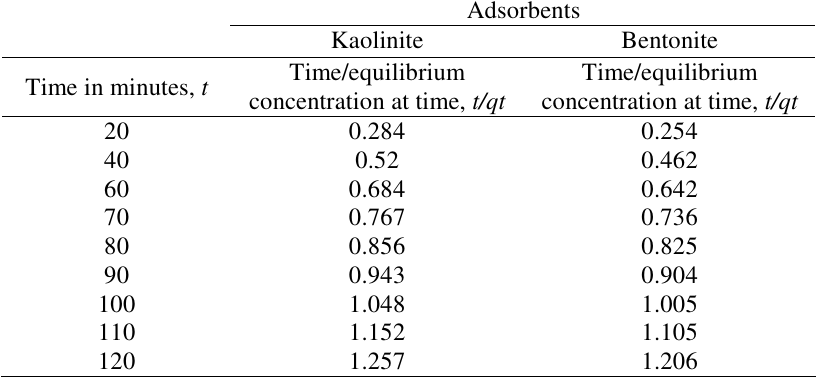
Table 9. Time profile and pseudo second order kinetics model for nickel(II) Contact time in min.,